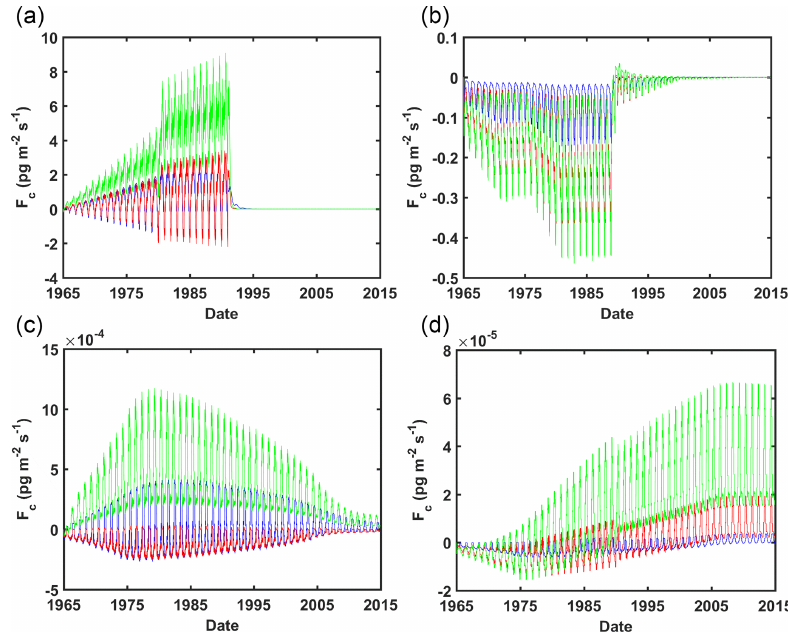
Figure 4. Predicted multidecadal diffusive air–surface exchange fluxes. 1-D model. F c (positive is upward, negative is downward; lower) of (a) α -HCH, (b) p, p (cid:48) -DDT, (c) PCB28, (d) PCB153 in the northern (29.7–33.4 ◦ N, blue), central (18.5–22.3 ◦ N, red) and southern (7.4– 11.2 ◦ N, green) zones of India during 1965–2014. Predicted concentrations in air and soil are shown in Fig. S3 in the Supplement.